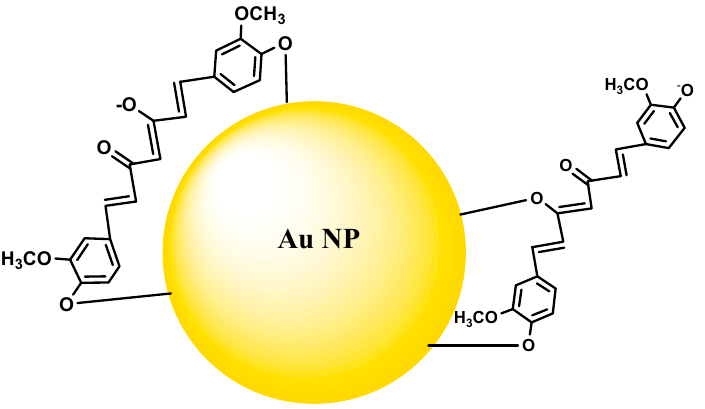
Figure 3. Gold nanoparticles capping by curcumin